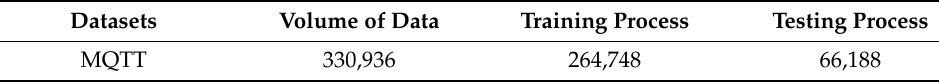
Table 3. Volume of datasets.